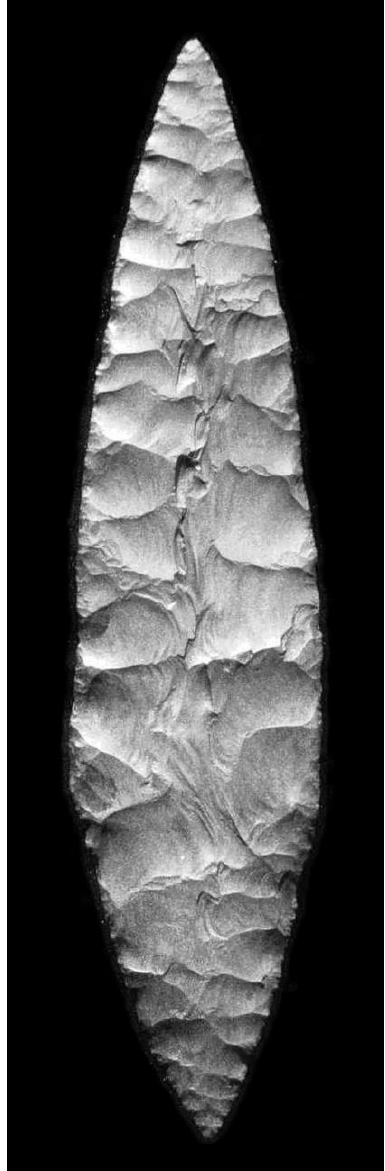
Figure 5. Solutrean laurel-leaf replica. (Photo by E.